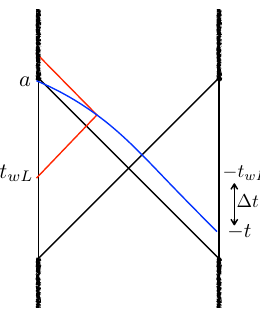
Figure 11 . Interior OTOC for the AdS 2 black hole.